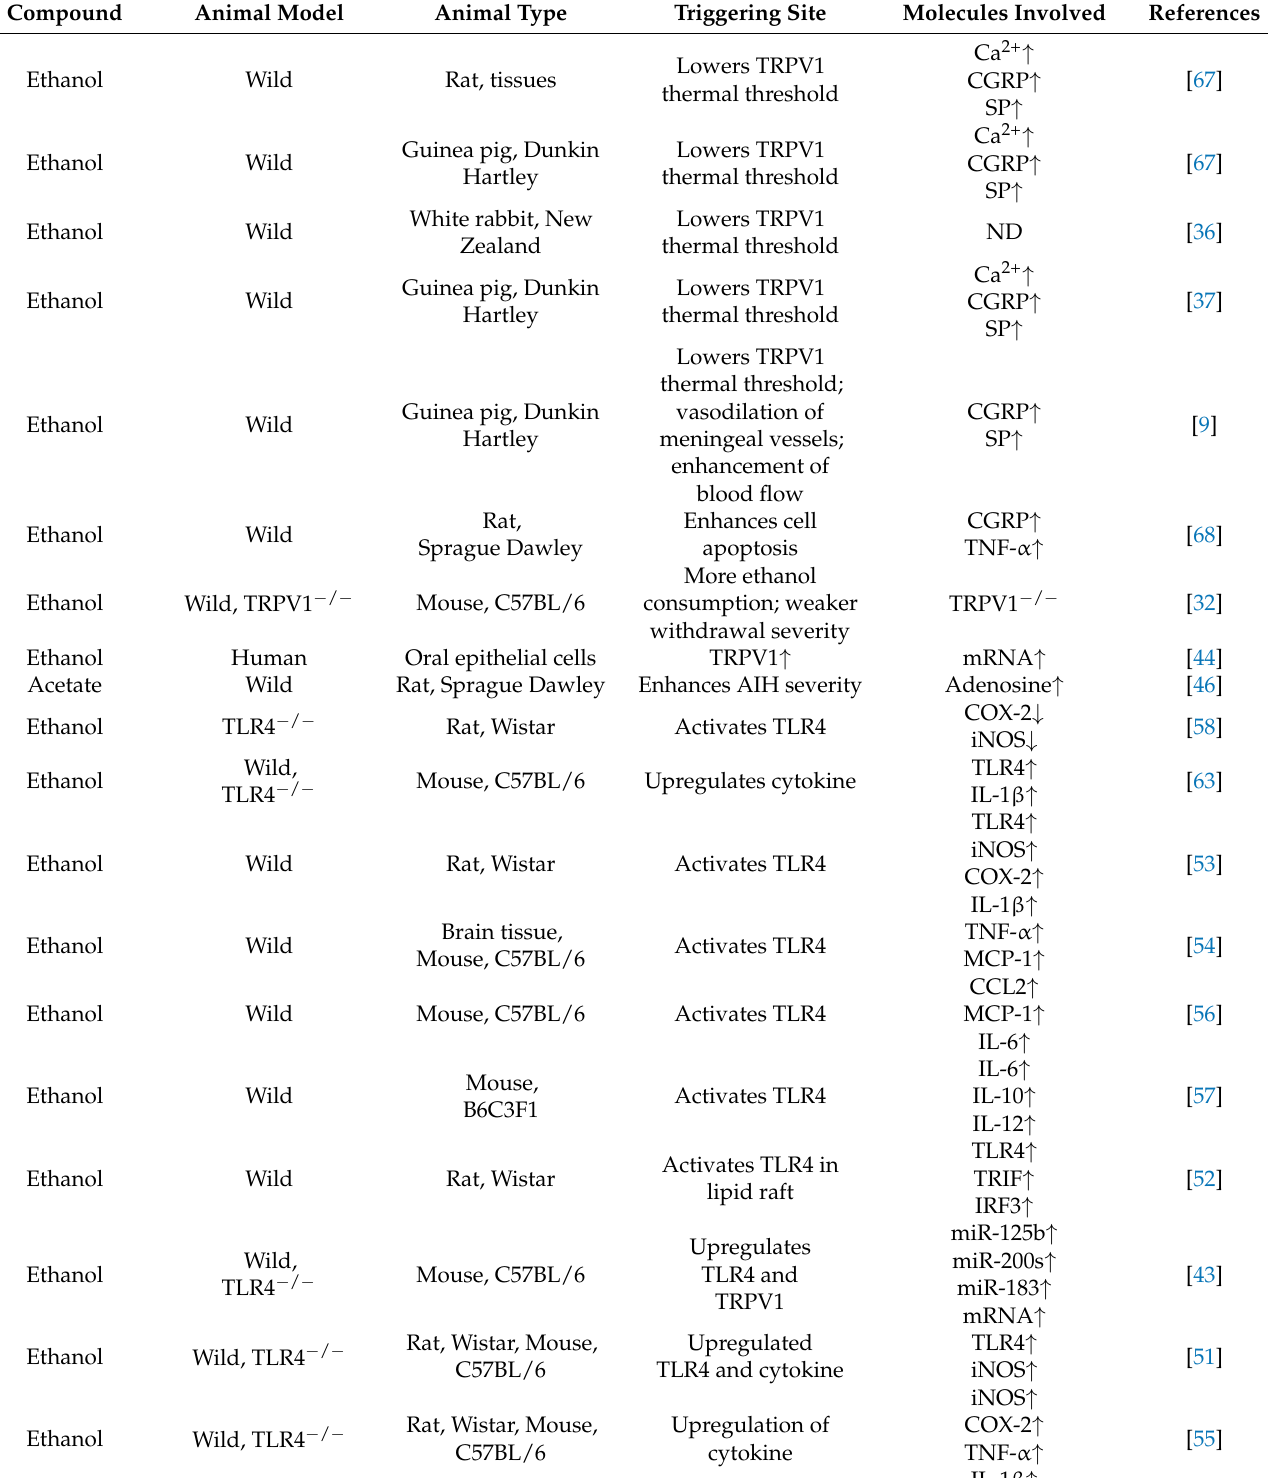
Table 1. Research on the effects of ethanol and its derivatives on AIHs and neuroinflammation in